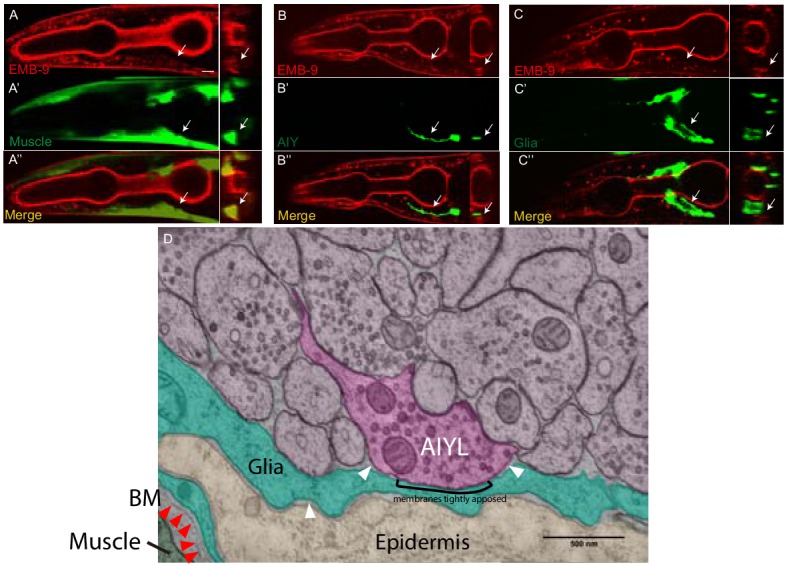
Localization of basement membrane near the nerve ring.(A–C’’) Confocal micrographs of the basement membrane marker EMB-9 (red) (A, B and C) with VCSC glia (green) (A’–A’’), AIY neuron (green) (B’–B’’) and body wall muscle (green) (C’–C’’). Panels on the right hand side of each column represent cross sections (in the area of the arrows in A, (B and C). The scale bar in (A) is 10 μm and applies to all panels. Notice how basement membrane marker EMB-9 localizes to muscles in the pharynx, and body wall muscles (arrows in A), proximal to the glia (C), but away from neurons in nerve ring such as AIY (B), consistent with EM (Figure 9 and D). These findings are consistent with the basement membrane being an organized extracellular matrix structure of 30–70 nm not present between neurons of the nerve ring neuropil, similar to reports for neurons in the CNS for other organisms (Heikkinen et al., 2014; Krishnaswamy et al., 2019). Our findings, however, can not exclude the possibility that basement membrane proteins can be expressed by neurons in the nerve ring. (D) High-magnification electron micrograph of tissue near AIY Zone 2 synapses, pseudocolored to show neuropil (pink), AIY (dark pink), glia (teal), epidermis (beige), and muscle (dark green). Basement membrane is visible between muscle and glia (red arrowheads), but not between glia and epidermis or glia and neuropil (white arrowheads). AIY and glial membranes appear tightly apposed at some regions. Scale bar 500 nm.